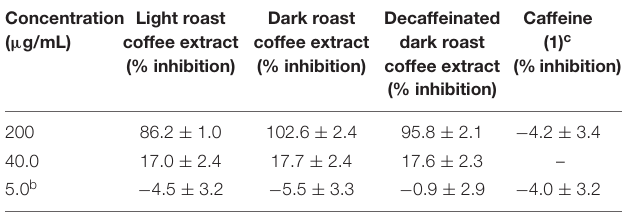
TABLE 2 | Inhibition of tau fibril formation by coffee extracts in ThS fluorescence assay.